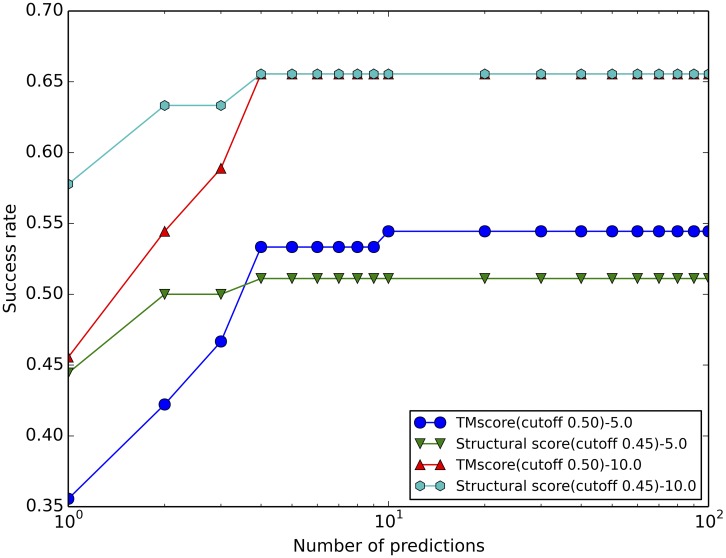
Benchmarking of template-based protein-RNA structure prediction.Targets (90 newer complexes) were predicted using templates (349 older complexes). The models are ranked separately by the complex structural score and by the TM-score. The docking of a complex was successful if at least one prediction within a set number of predictions was successful (RMSD between predicted and native structures ≤ 5 Å for "medium" and ≤ 10 Å for "acceptable", see Methods). Score with cutoff X means that the model is built from the template with a target/template score larger than the transition point X.